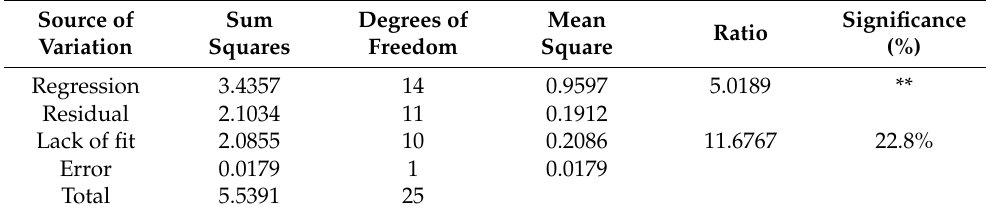
Table 6. Analysis of variance for phycoerythrin production response.